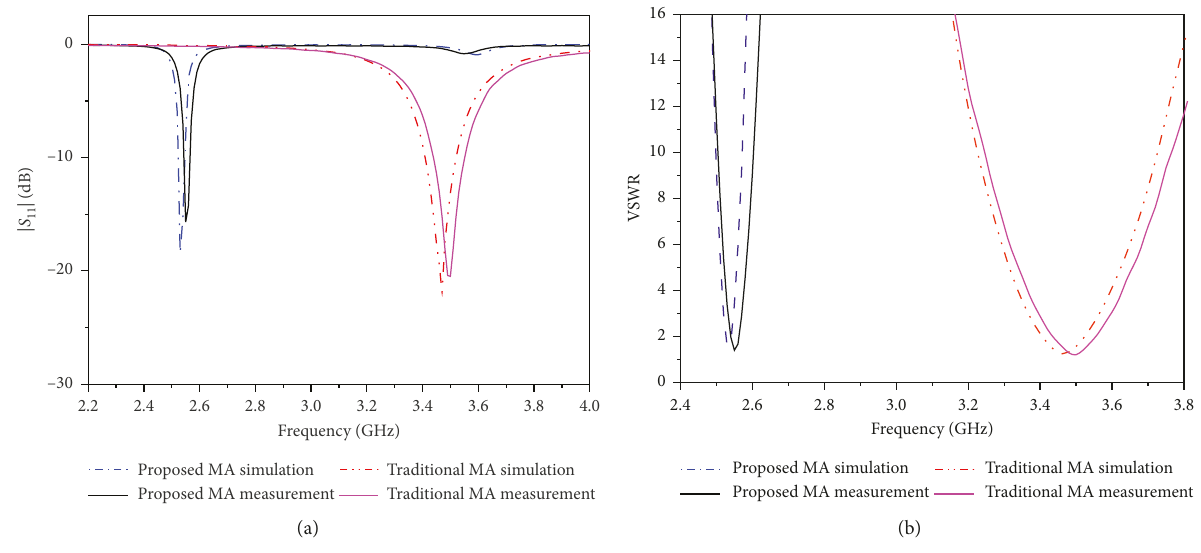
Figure 6: Simulated and measured (a) S 11 and (b) VSWR of the proposed and traditional